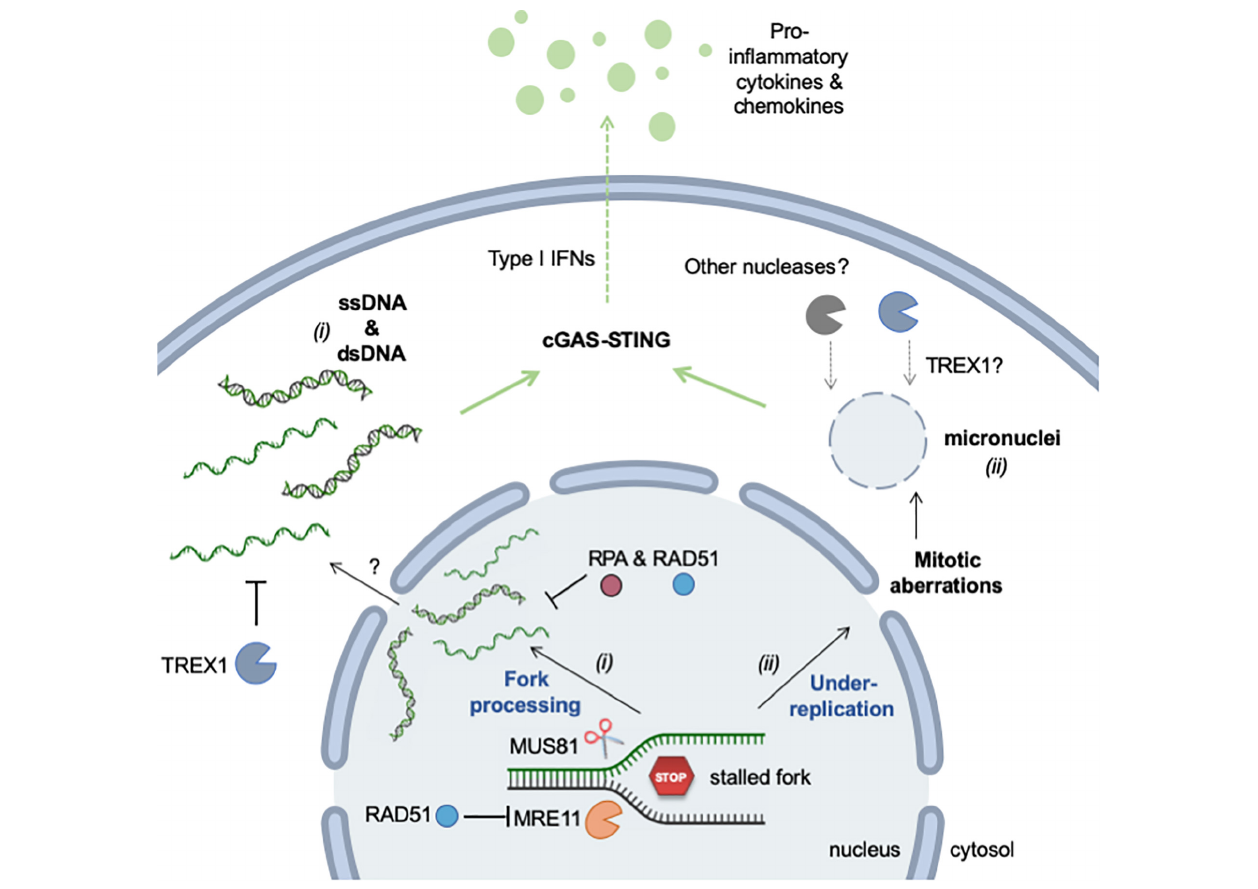
FIGURE 4 | Mechanisms of RS-induced accumulation of cytosolic (self-) DNA. Self DNA accumulates in the cytosol when mammalian cells are exposed to RS-inducing agents (e.g., HU, APH, CPT) or when cells are deficient for factors promoting replication fork stability (e.g., SAMHD1). The release of genomic DNA occurs in two different ways. ( i ) DNA fragments (ssDNA and dsDNA) are released from stalled forks by nucleolytic cleavage (MRE11 and MUS81). The mechanism by which these fragments exit the nucleus is currently unknown, but it is repressed by RPA and RAD51. TREX1 is the major cytosolic exonuclease that degrades DNA to prevent the activation of the cGAS-STING pathway. ( ii ) Incomplete replication, known as under-replication, induces chromosome segregation defects and leads to the formation of micronuclei and to other mitotic defects. Upon rupture of their membrane, cGAS localizes to micronuclei and activates STING. Whether TREX1 or other nucleases can access DNA inside micronuclei is not known. See text for additional details. This figure was created in part with